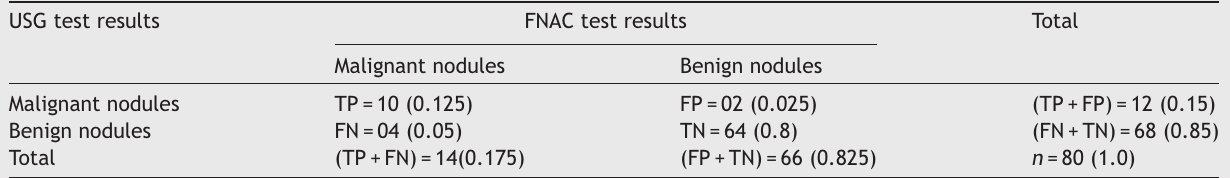
The generic 2 × 2 table with number of cases assigned to malignant and benign nodules, based on USG test and fine needle aspiration cytology (FNAC) test during diagnosis of thyroid nodules.